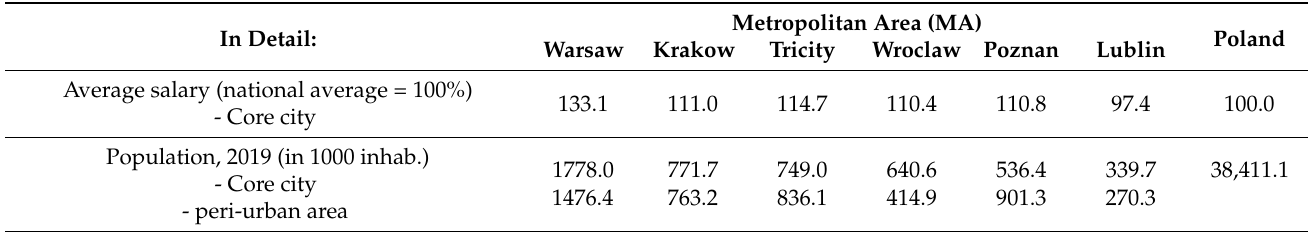
Figure 2. Metropolitan areas falling within the scope of the study. Source: own work. Table 1. Socio-economic characteristics of the studied metropolitan